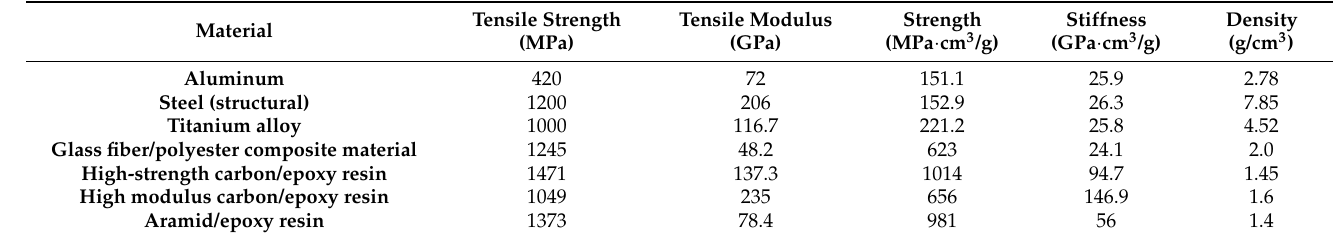
Figure 1. Early static aeroelastic experiment model, Reproduced with permission from [33]. Table 1. Comparison of materials properties used in aeroelastic model manufacture.